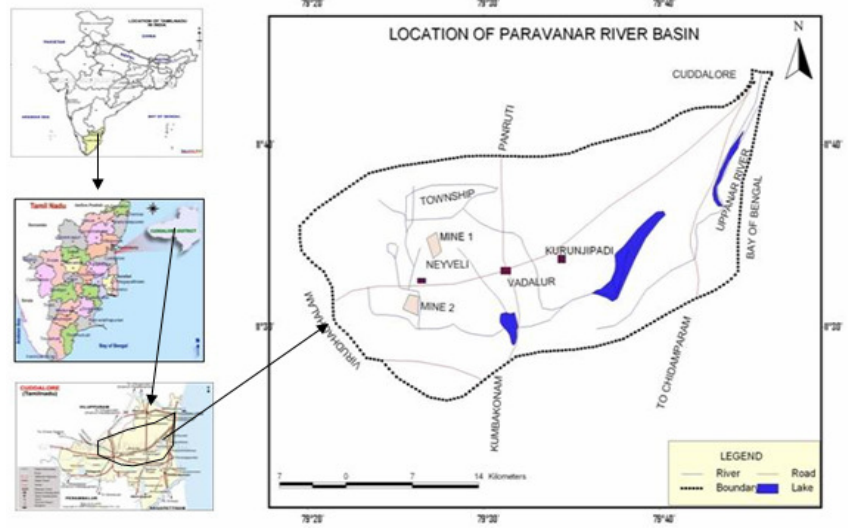
Figure 1. Location map of the study